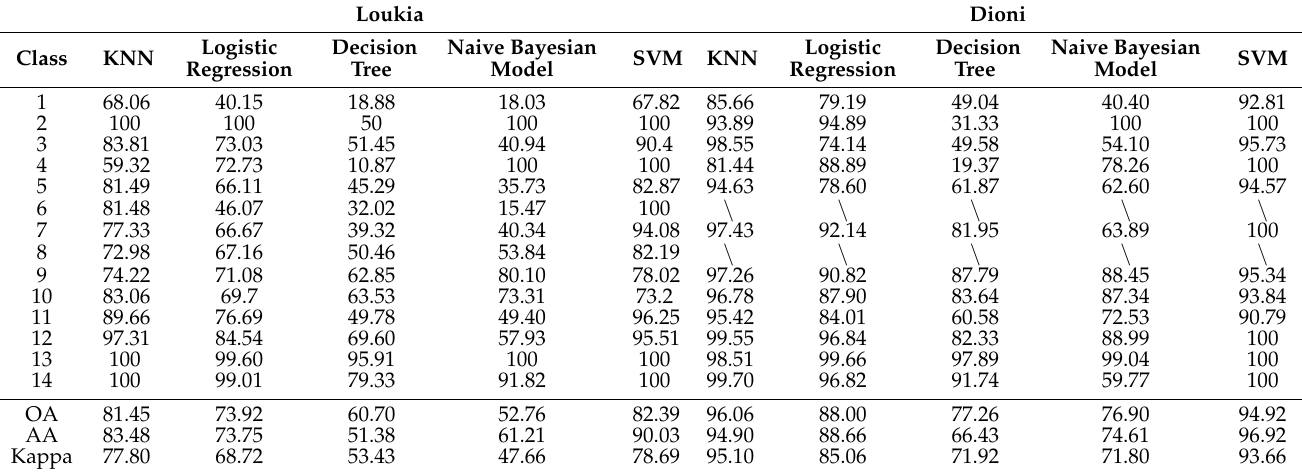
Table 6. Classification accuracy (%) for Loukia and